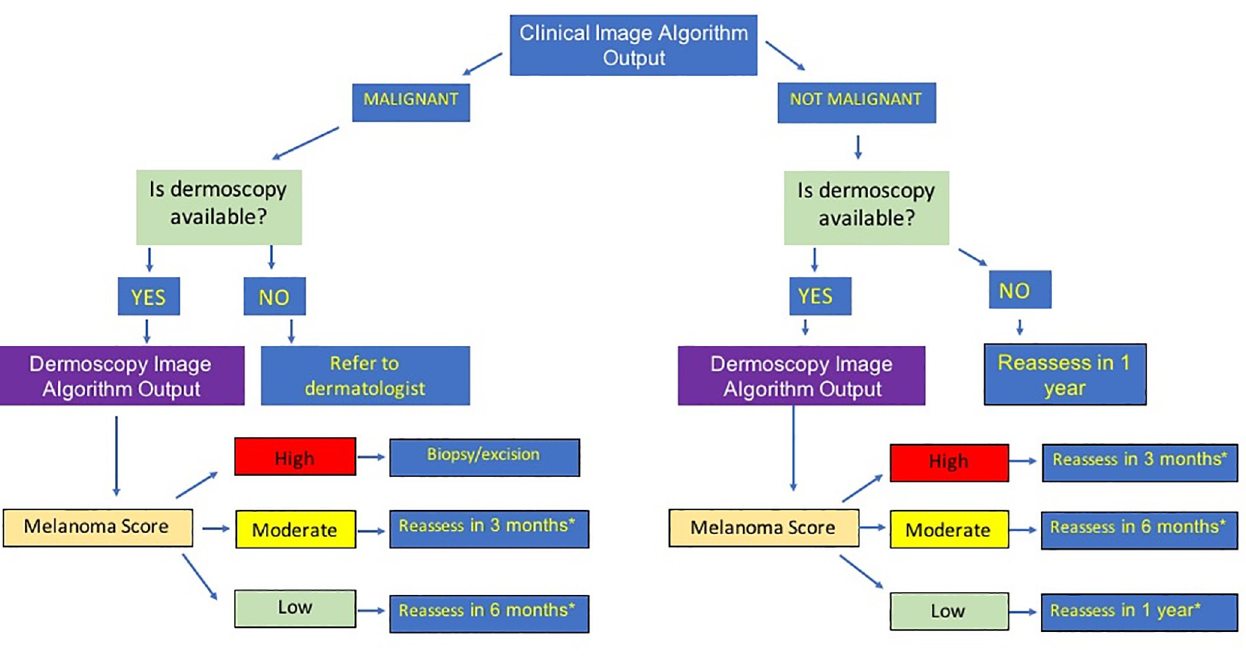
Fig 3. Possible clinical and dermoscopy algorithms outputs and suggested care for each scenario: The second tab was entitled: “Understanding the Heat Map”, with a brief explanation on how to interpret the Heat Map. The third tab has a short text about how uncertainty is inherent to AI algorithms and the fourth and last tab “Who we are” describes the multidisciplinary work group that developed the algorithm. More information about these tabs can be found in S2 File.